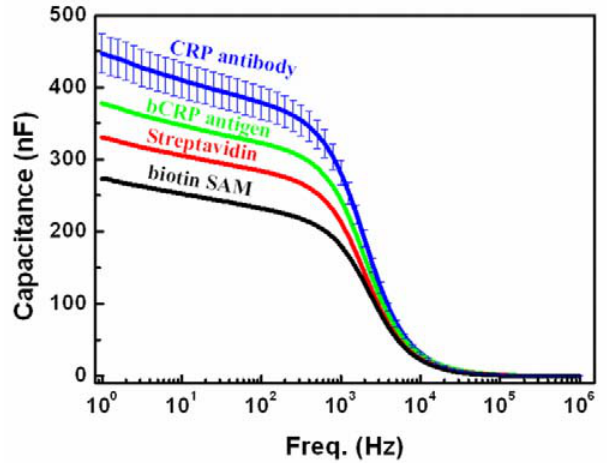
Figure 7. Capacitance as a function of frequency after each immobilized